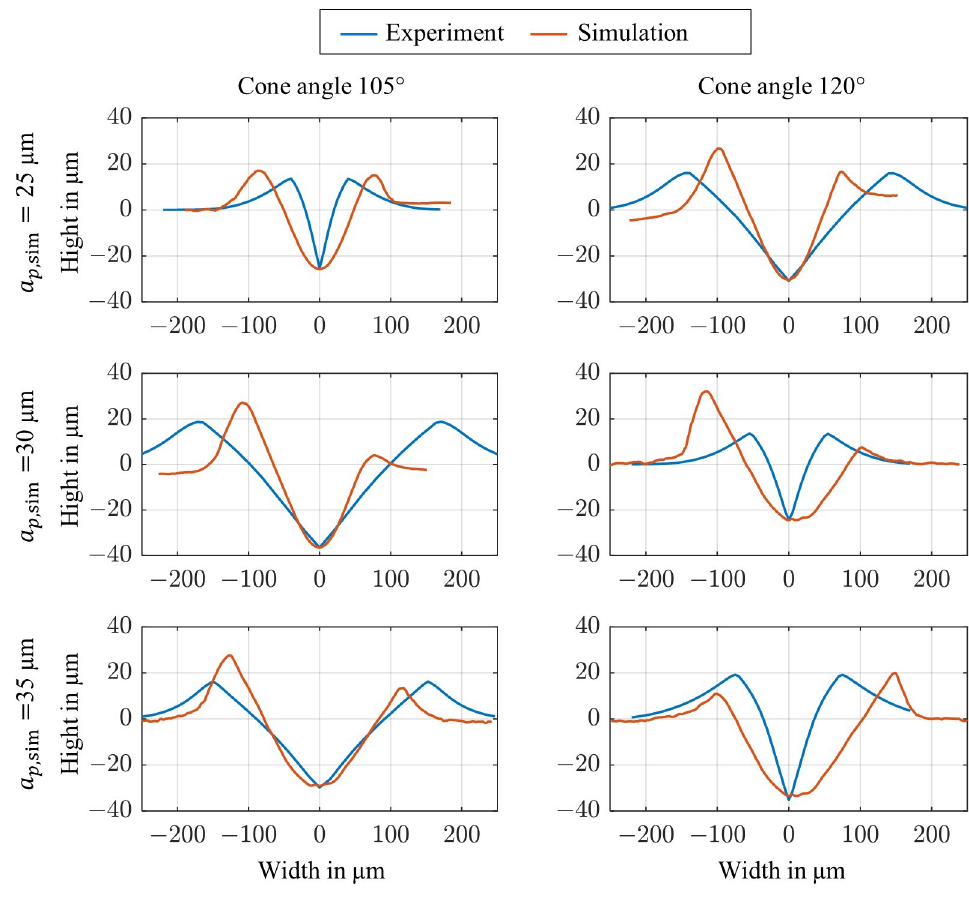
Figure 15. Measured and simulated 2D surface scratch topographies for cone angles 105 ◦ and 120 ◦ and depth of cut between 25 µm and 35 µm (cutting speed v c = 200